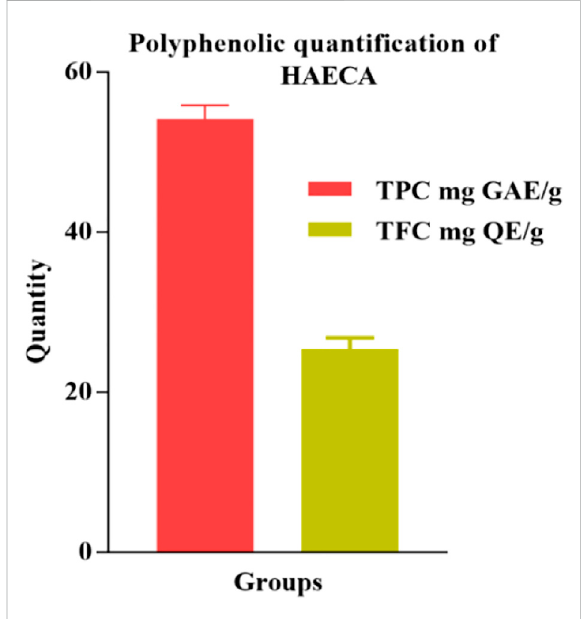
FIGURE 1 Total polyphenolic content in hydro-alcoholic extract of Cardamine amara (HAECA).